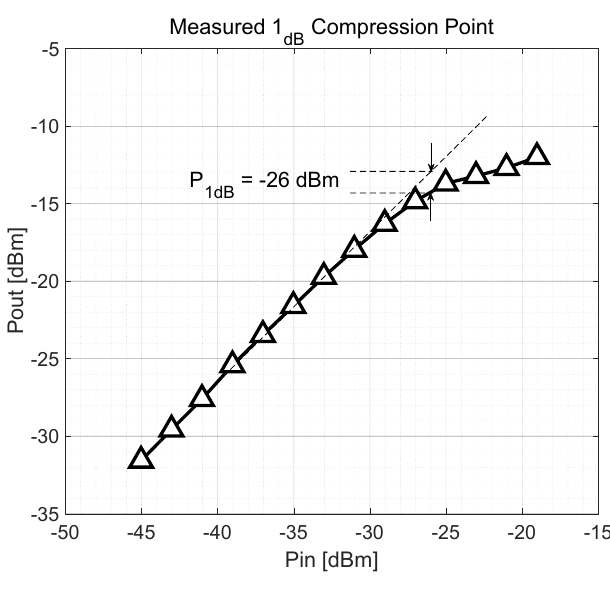
Figure 20. Measured IP 1 dB